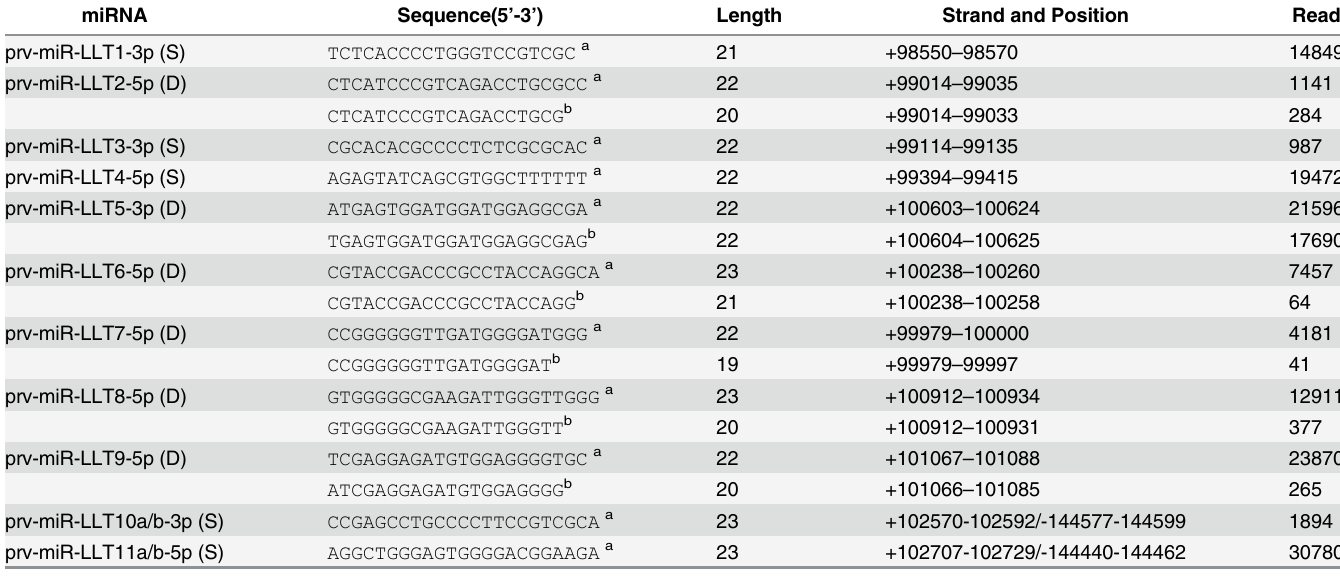
Table 2. The differences (D) or similarities (S) between the known viral miRNAs from JS-2012 strain and miRBase.